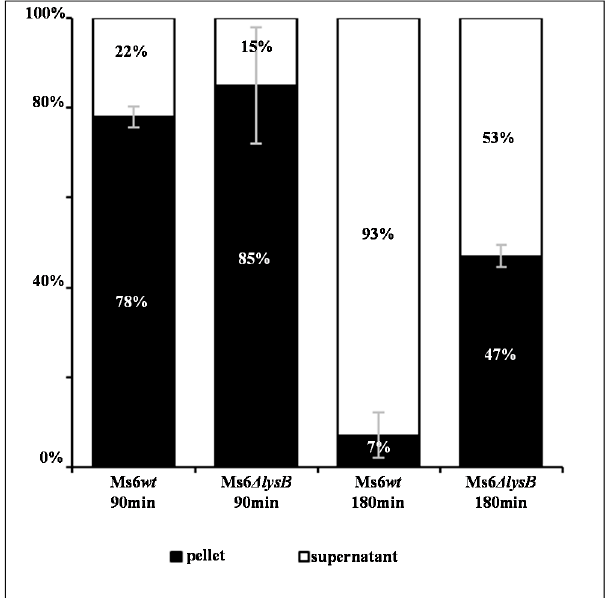
Figure 3. Distribution of phage particles in the supernatant and pellet of M. smegmatis infected with Ms6 wt or Ms6 ∆ lysB . Ms6 is trapped in cell debris in absence of LysB. At the indicated time points, the distribution of phage particles in the pellet and in the supernatant was determined as a percentage of the total amount of PFU counted in both fractions. The values indicate the mean ± SD of three independent experiments.